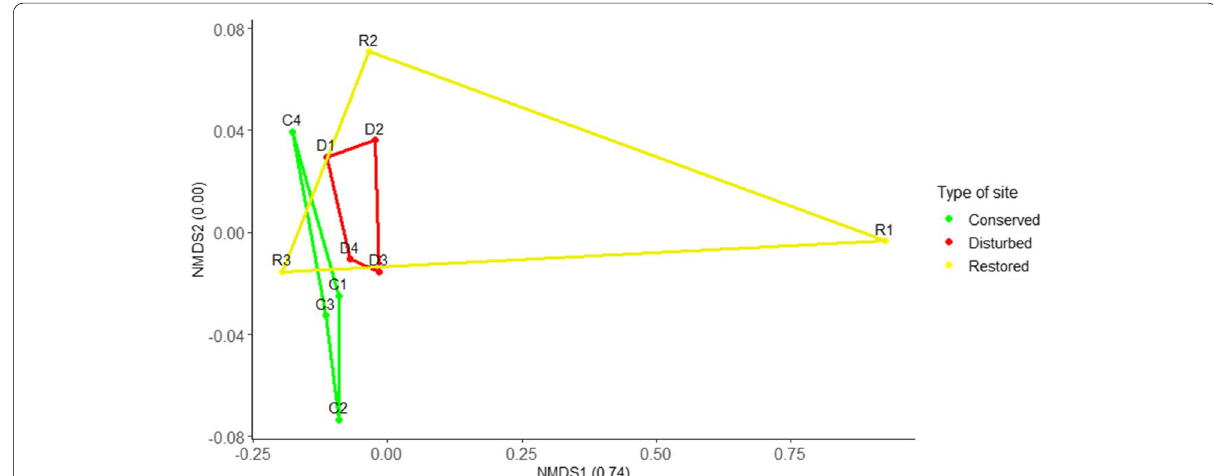
Fig. 6 Non‑metric Multidimensional Scaling showing the ordination of the 11 study sites in the PSAER, based on taxonomic orders. Dots represent conserved sites; triangles represent disturbed sites and squares represent restored sites. The lines are the convex hulls of the polygons formed in each case